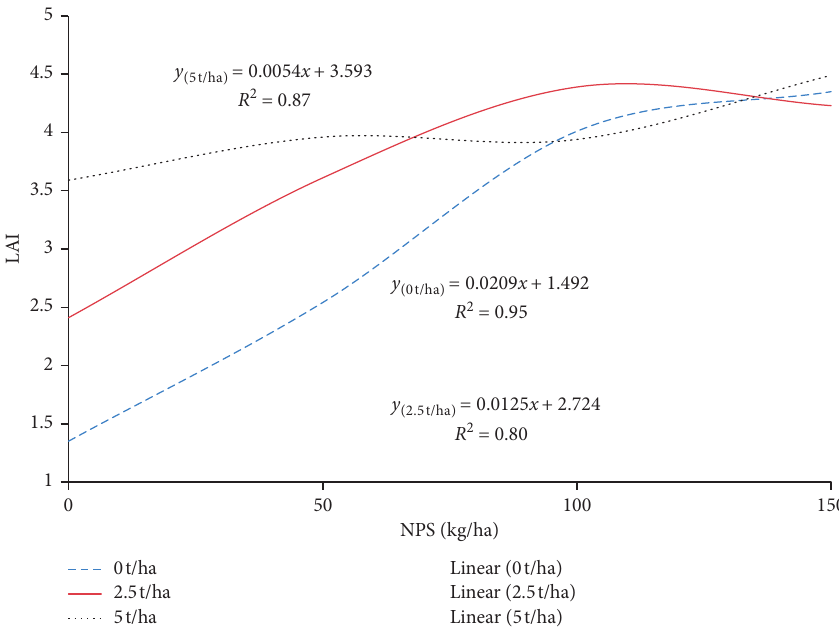
11.522.533.544.55 Figure 1: Leaf area index of haricot bean as affected by interaction effects of NPS and organic Figure 2: Number of pods/plant of haricot bean as affected by interaction effects of NPS and organic fertilizer.